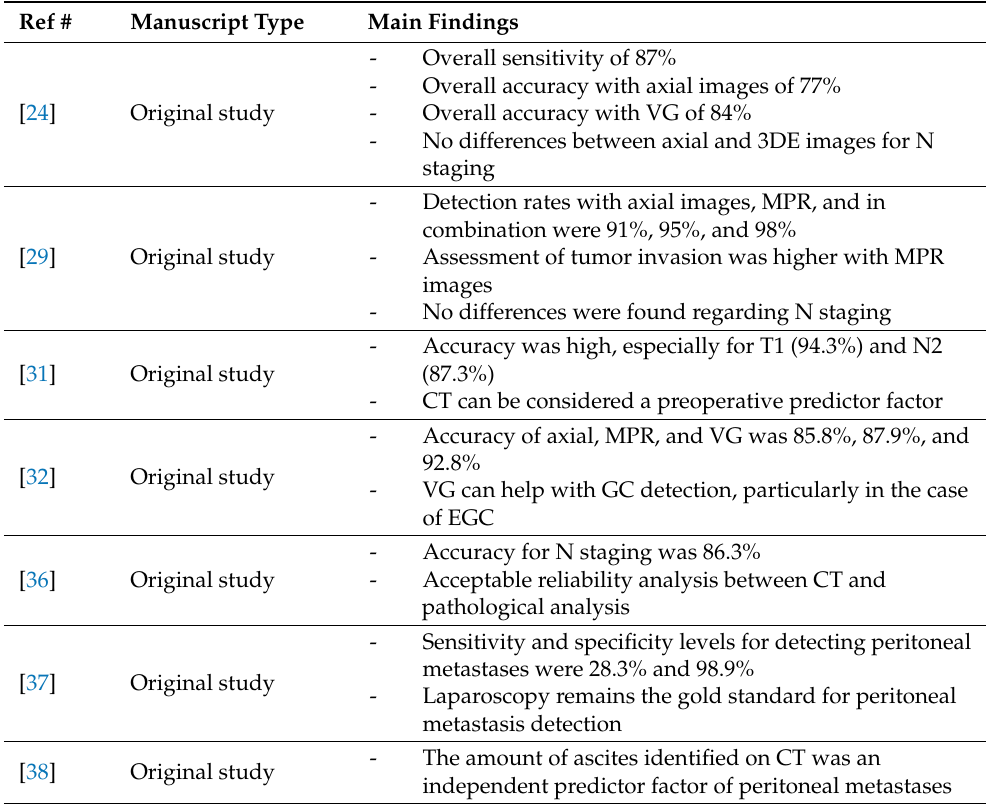
Table 3. Details of the most important papers regarding the usefulness of CT in the staging of GC